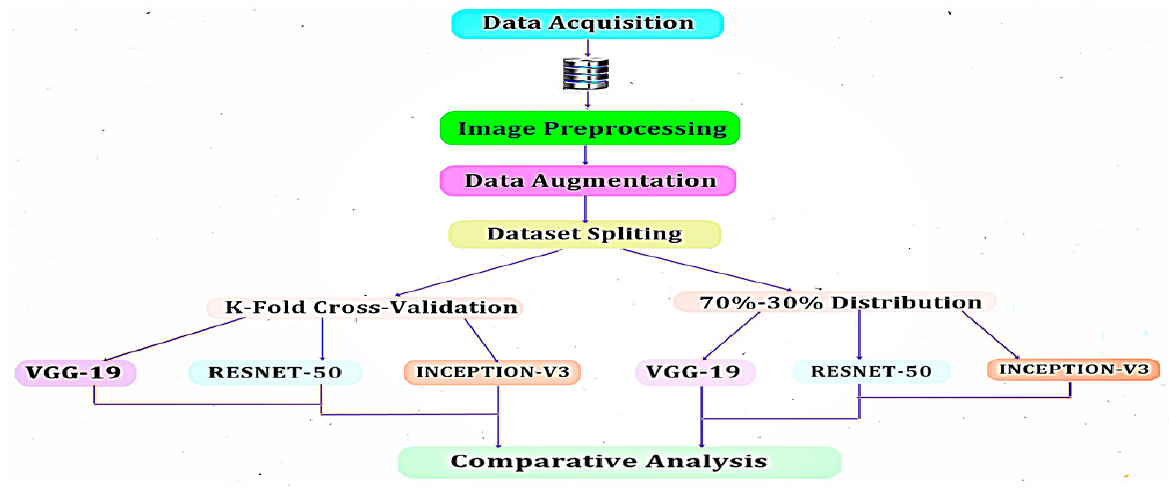
Figure 4. Proposed framework for COVID-19 detection using imagery data.